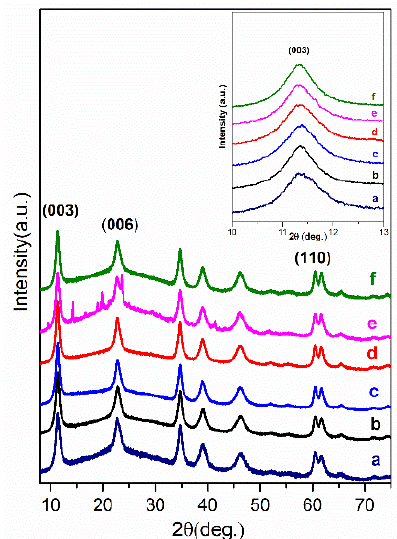
Figure 4. XRD patterns of Mg 3 /Al 0.99 Eu 0.01 -CO 3 ( a ) and hybrid inorganic-organic LDHs: Mg 3 /Al 0.99 Eu 0.01 -succinate ( b ), Mg 3 /Al 0.99 Eu 0.01 -malonate ( c ), Mg 3 /Al 0.99 Eu 0.01 -tartrate ( d ), Mg 3 /Al 0.99 Eu 0.01 -laurate ( e ) and Mg 3 /Al 0.99 Eu 0.01 -oxalate ( f ). Materials 2019 , 12 , x FOR PEER REVIEW